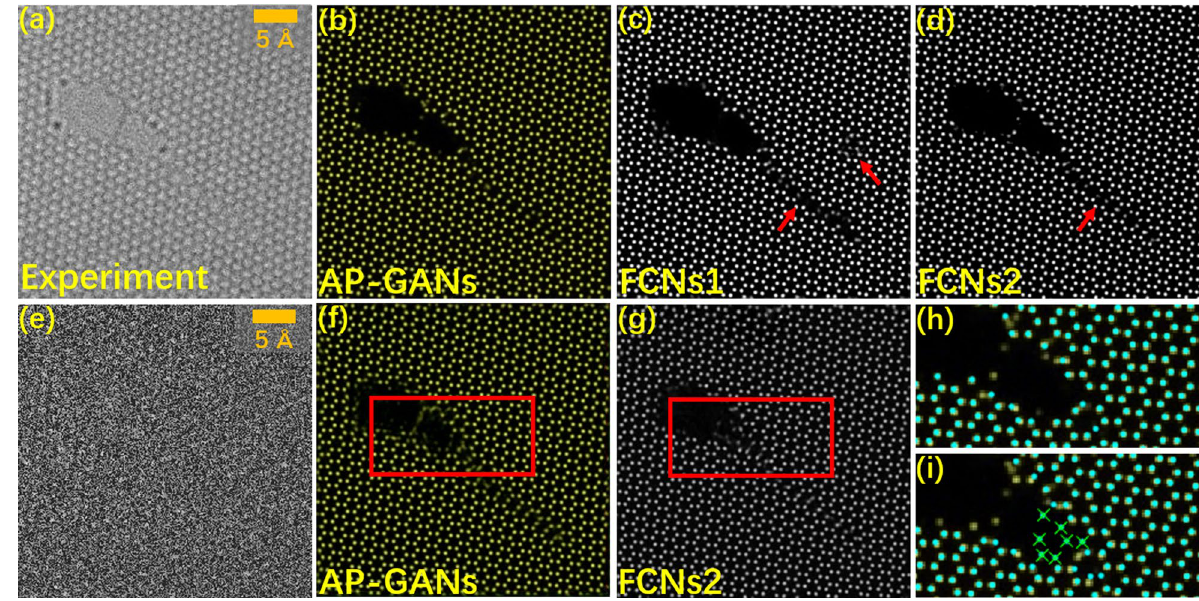
Figure 4. Comparison of the predictions of AP-GANs, FCNs1 and FCNs2 for the same experimental images in the test set. ( a ) The experimental image, and ( b – d ) their probability maps were obtained via ( b ) the proposed AP-GANs, ( c ) FCNs1 in 21 and ( d ) FCNs2 in 22 . ( e ) Imitated low-dose image simulated from ( a ). ( f , g ) Atom maps were predicted by using ( f ) AP-GANs and ( g ) FCNs2, respectively. ( h , i ) Regions extracted from ( f ) and ( g ), respectively. The darker yellow dots were estimated from ( a ) normal images via using AP-GANs and FCNs2, and green dots were predicted by ARP and green crosses highlight the clear